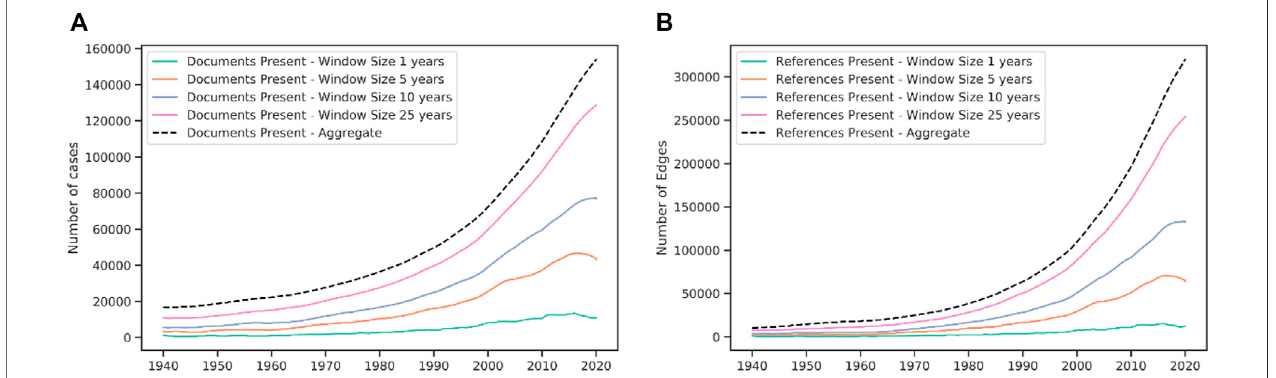
FIGURE 5 | Evolution of the cross-jurisdictional network. (A) Nodes and (B) edges present over time and four window widths, τ (cid:1) { 1 , 5 , 10 , 25 } .